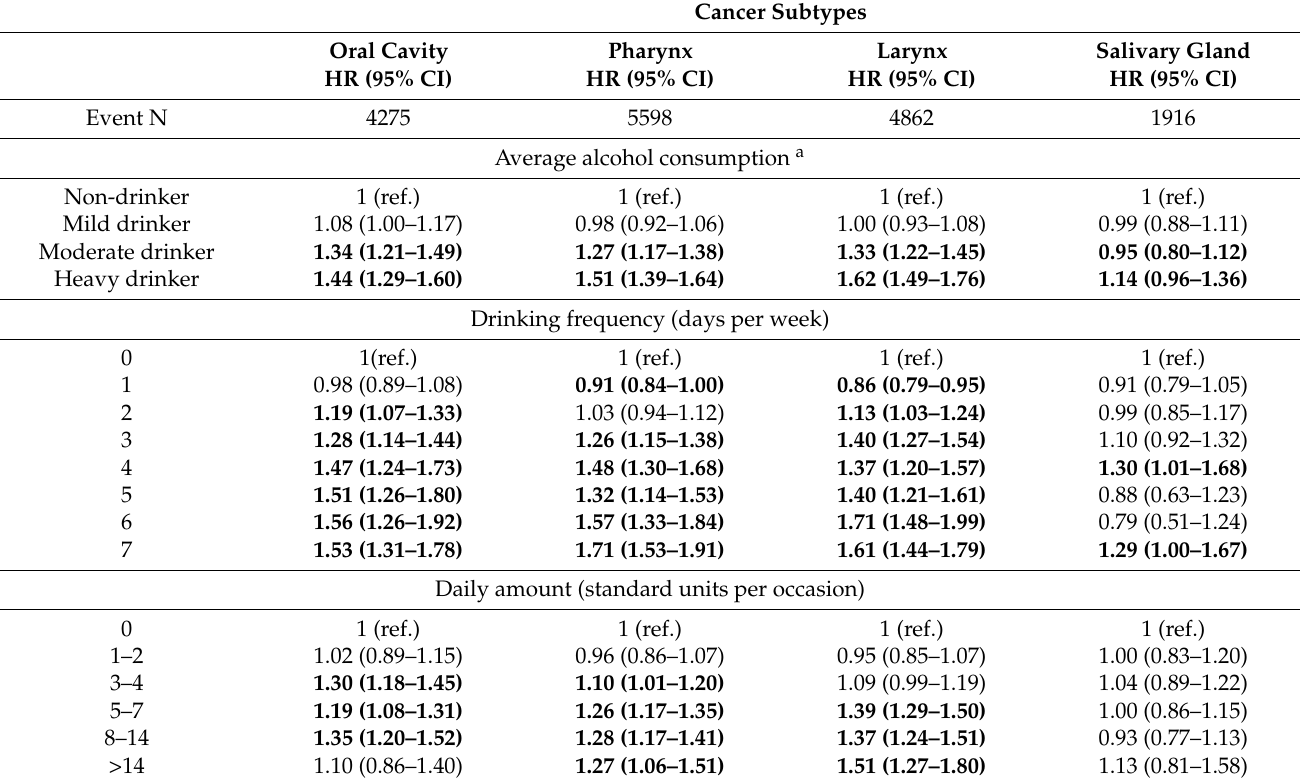
Table 3. Risks of head & neck cancer subtypes according to drinking